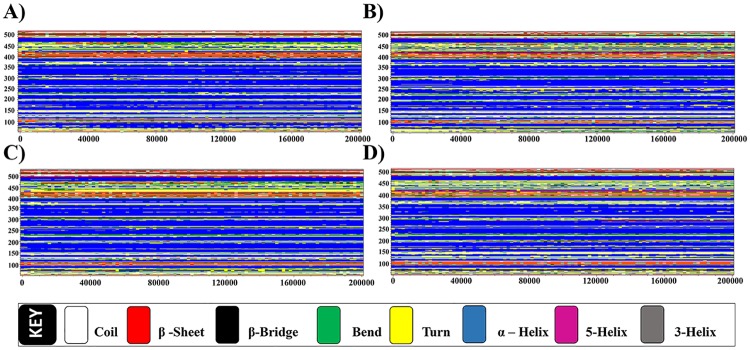
Time evolution of secondary structure analysis of (A) CYP24A1apo (B) CYP24A1ketoconazole(C) CYP24A1CTA-091(D) CYP24A1CTA-018.